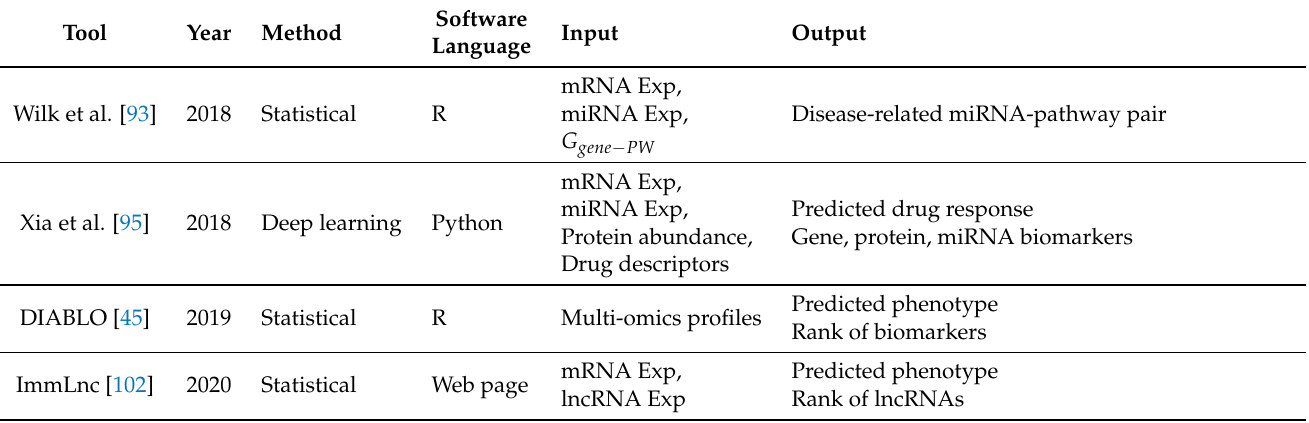
Table 5. Detailed information of representative ncDA prediction tools using ncRNA–mRNA– graph of i and j